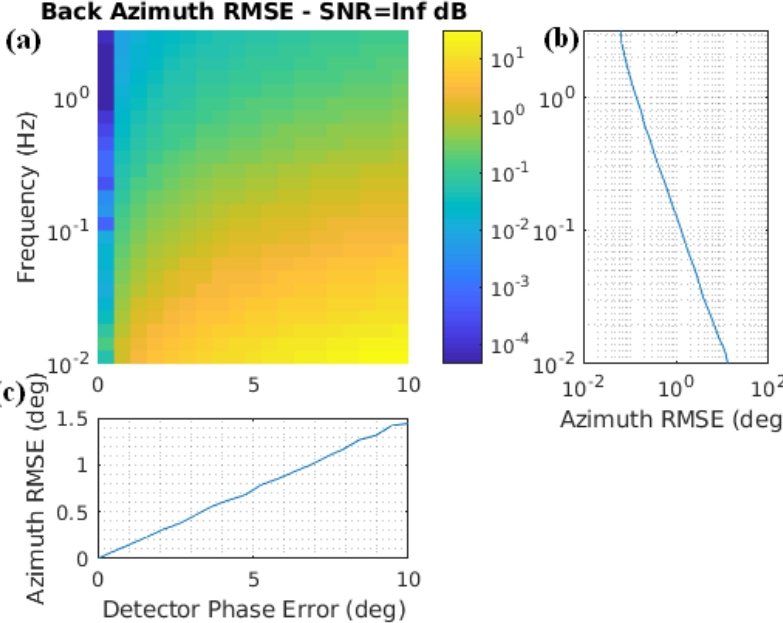
Figure 19. The color plot ( a ) shows the back azimuth RMSE for a case with no noise, and a consistency threshold of 0.1 s, as a function of frequency and sensor phase error. The color is the back azimuth RMSE using a log scale. The panel to the right ( b ) is the median back azimuth RMSE over all sensor phase errors, which is essentially the RMSE for a phase error of 5°; hence, the RMSE is observed at the IMS acceptable limit for the sensor response. The bottom plot ( c ) is the median RMSE over all frequencies, thus showing the dependency of the RMSE on the sensor phase error.